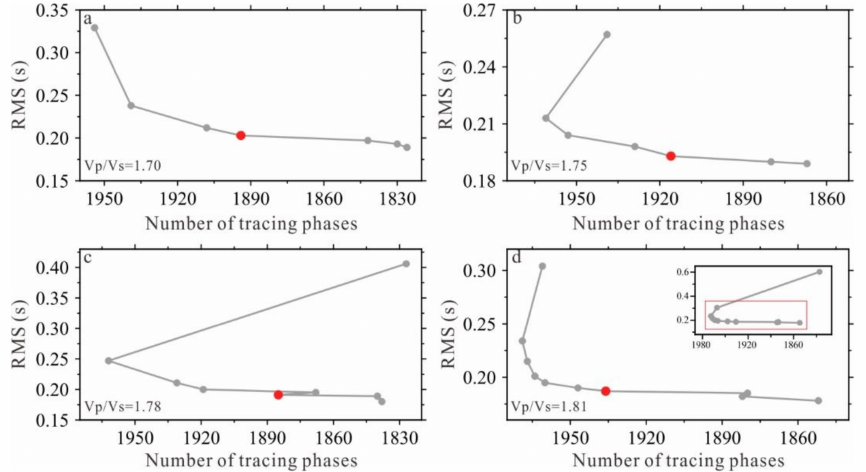
Figure 10. Variation in the number of tracing phases and travel-time residuals (RMS) during the inversion process under the initial models with the Vp/Vs ratios of 1.71 ( a ), 1.75 ( b ), 1.78 ( c ), 1.81 ( d ). Red dots indicate inversion is terminated at this time.